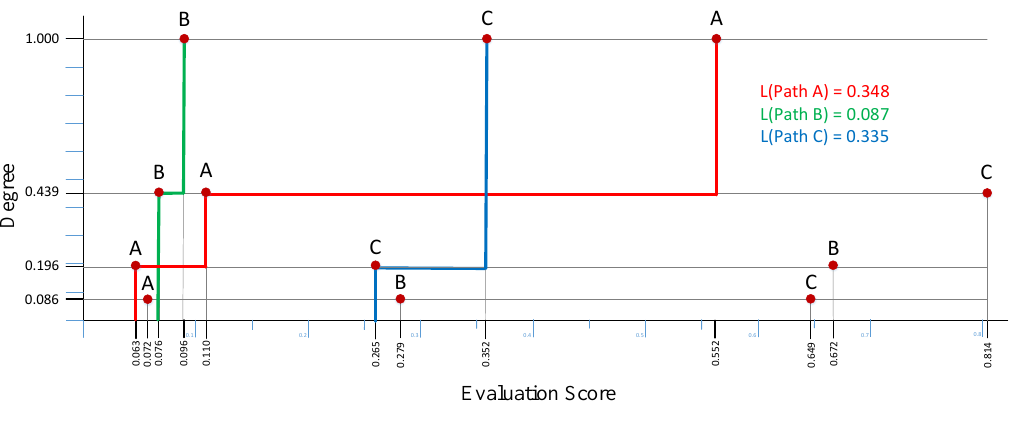
Figure 3. L-Evaluation (Lower Model). Figure is not to scale.